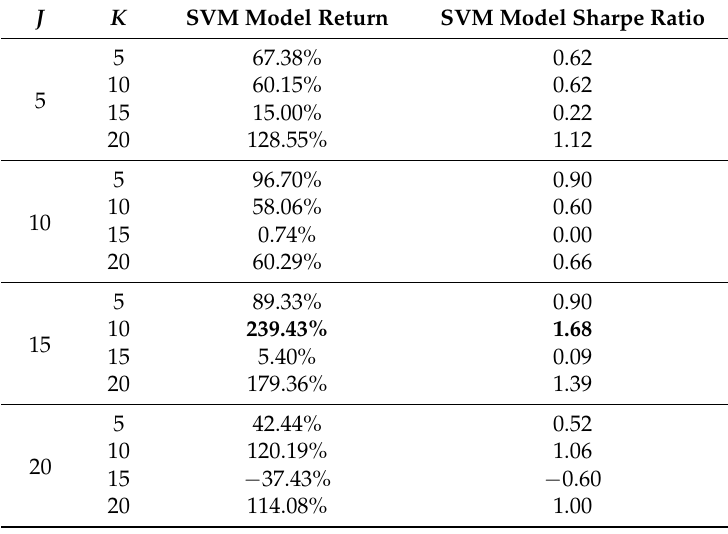
Table 7. Performance of the Support Vector Machine (SVM)